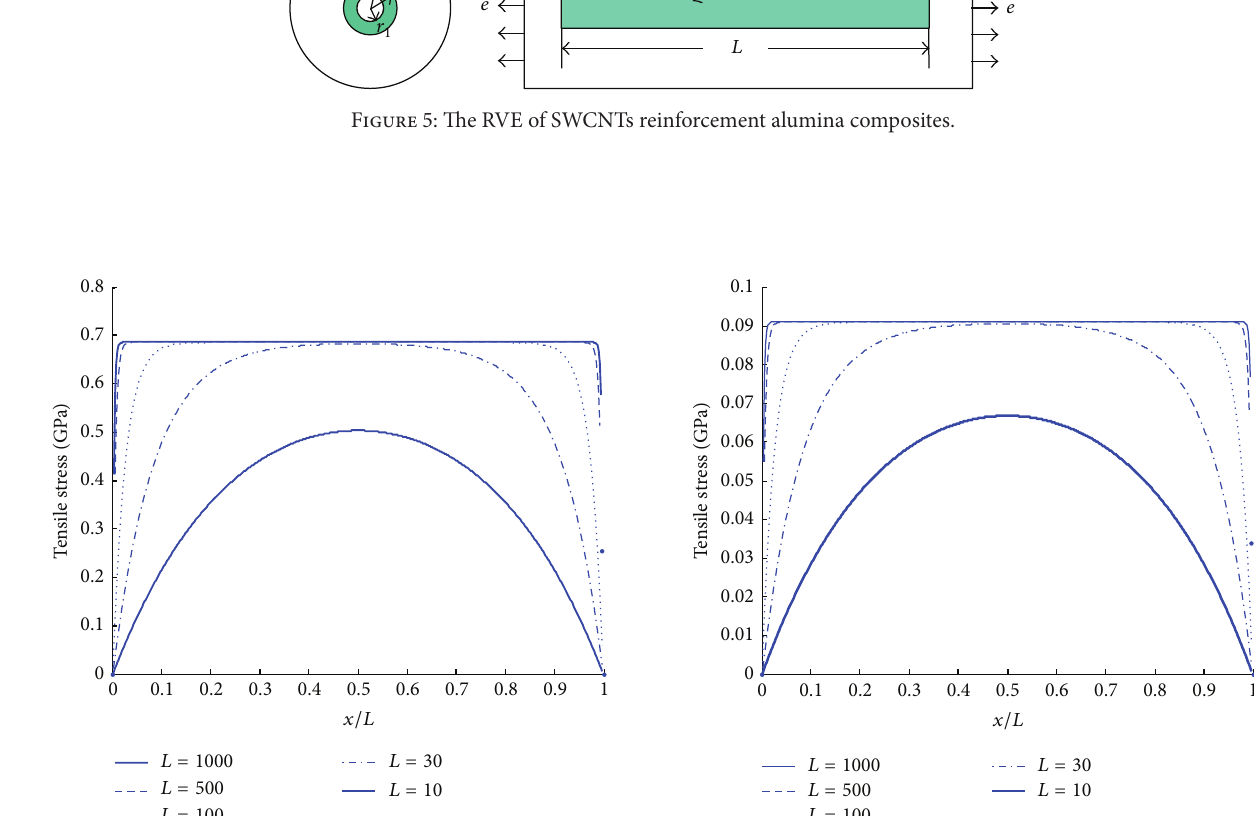
Figure 6: Tensile stress distributions at various tube lengths ( 𝑑 = 3 nm, 𝑡 = 0.34 nm).